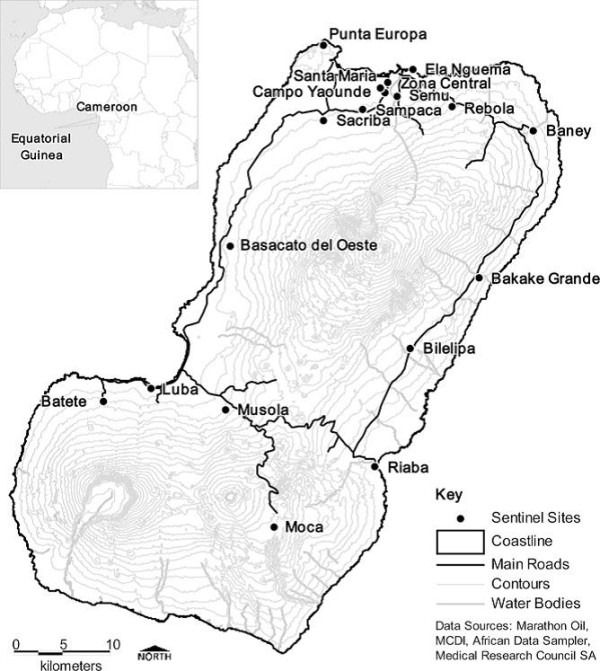
Sentinel sites in Bioko Island participating in the study. Map reproduced from Kleinschmidt et al [26]. MCDI = Medical Care Development International; SA = South Africa.